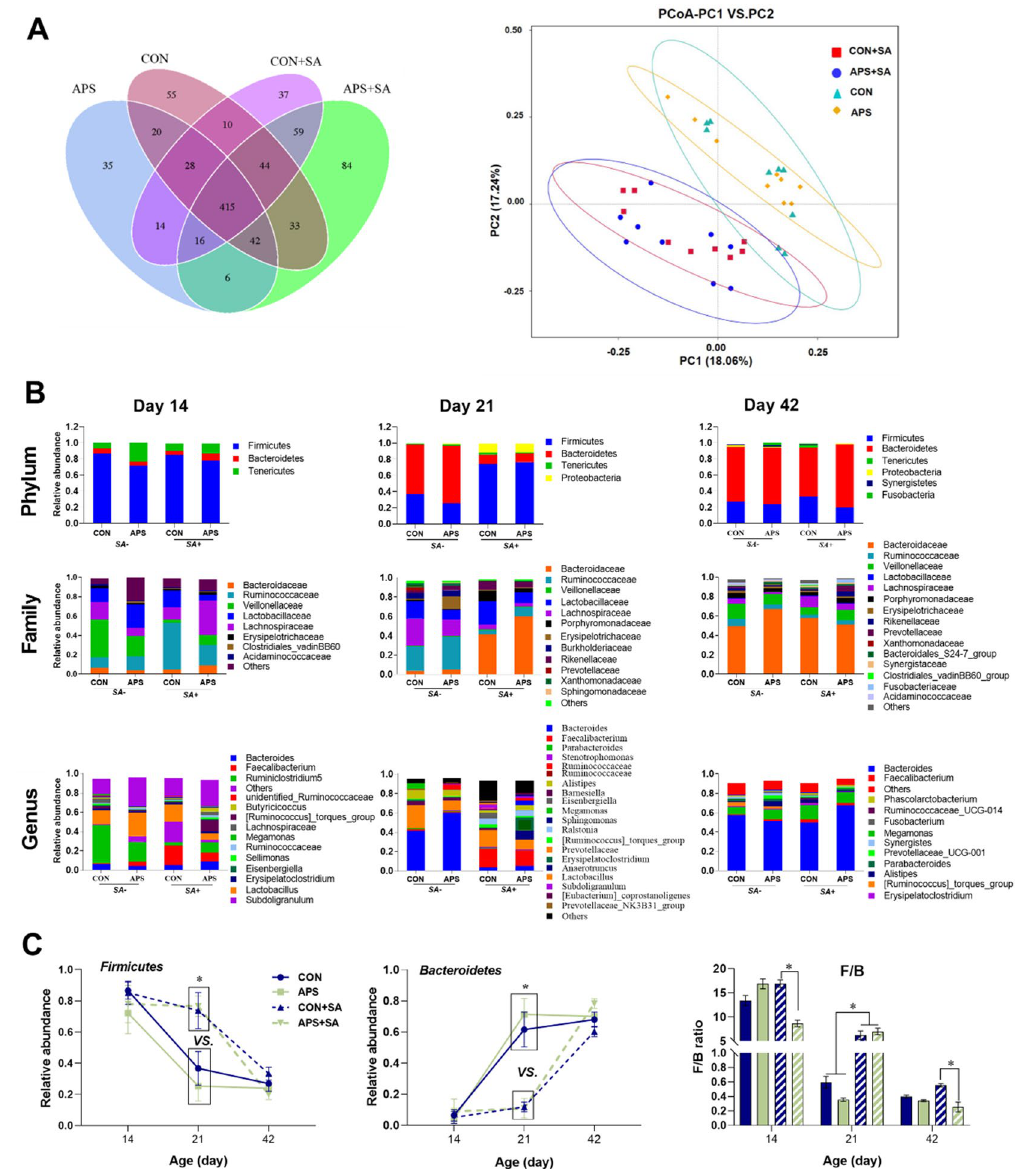
Figure 3. The OTU numbers and relative abundance values in the cecal microbiota at the phylum, family, and genus levels. ( A ) OTU number Venn plot and PCoA score plot for the different groups, ( B ) Relative abundance values in the cecal microbiota of broilers at 14, 21 and 42 days of age at the phylum, family, and genus levels, ( C ) Changes in the abundance values of the dominant phyla Firmicutes and Bacteroidetes and their ratio (F/B) in different ages of broilers. Only microbes that had a mean relative abundance greater than 1% are displayed in this figure. CON, control pair-fed group; APS, APS-supplemented pair-fed group; CON + SA, control S. ser. Enteritidis -challenged group; APS + SA, APS-supplemented S. ser. Enteritidis -challenged group; SA + , S. ser. Enteritidis -challenged groups; SA- , pair-fed richness of Bacteroidetes and Firmicutes altered to a less extent for CON + SA and APS + SA groups than that of CON and APS groups on day 21. At 14 days of age (the first administration of S. ser. Enteritidis ), the proportions of the phylum Firmicutes (regardless of treatment) were 86.66%, 72.10%, 85.21%, and 77.95% in the CON, APS, CON + SA, and APS + SA groups, respectively, while the Bacteroidetes richness accounted for 6.45%, 4.27%, 5.04%, and 8.99% of the total abundance, respectively (Fig. 3B, Supplementary Table S2). APS supplementation decreased ( P < 0.05) the ratio of Firmicutes to Bacteroidetes (F/B values). At 21 days of age, the abundance of Firmicutes was similar in the CON + SA (73.80%) and APS + SA (76.57%) groups and was higher than that in the CON (36.68%) and APS (25.31%) groups. In contrast, the richness of the phylum Bacteroidetes in the CON (61.57%) and APS (71.26%) groups was higher than that in the CON + SA (11.87%) and APS + SA (10.92%) groups ( P = 0.034). The F/B val- ues of the CON + SA and APS + SA groups were significantly higher than those of the pair-fed groups ( P < 0.05)